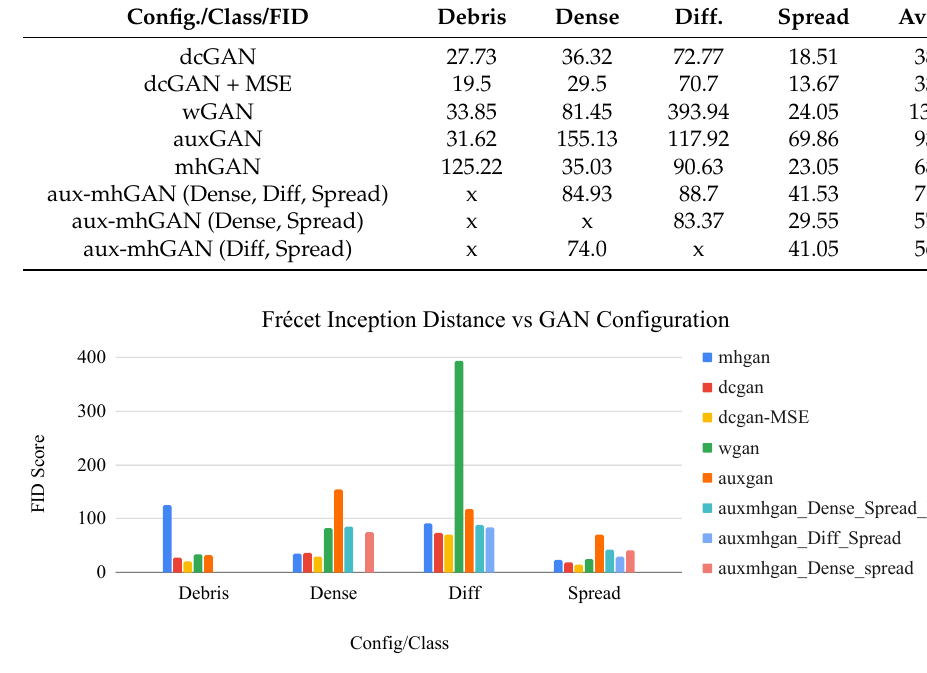
Figure 9. Bar graph of network configuration vs. FID score by image class. The dcGAN+MSE configuration consistently displays the best performance in terms of this